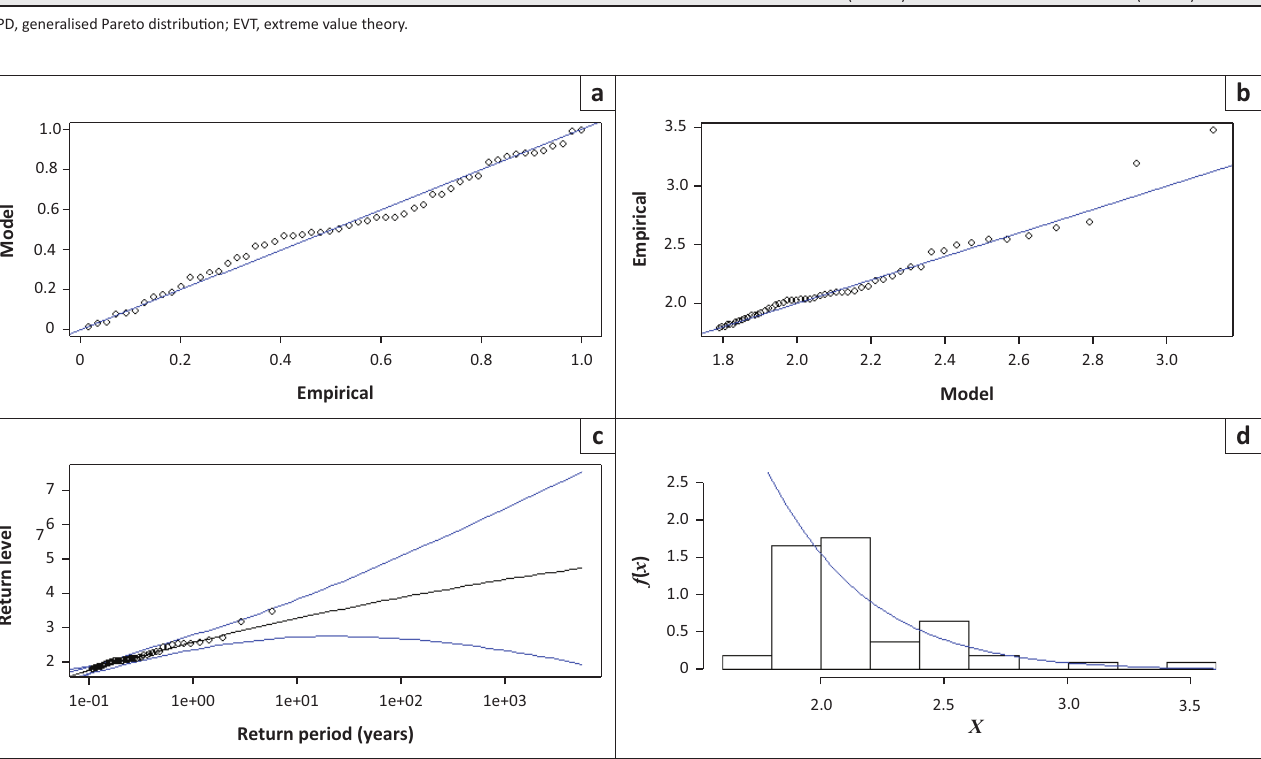
FIGURE 6: Diagnostic plots for the asymmetric power auto-regressive conditional heteroscedastic (1,1)–generalised Pareto distribution model. (a) Probability plot, (b) quantile plot, (c) return-level plot and (d) density